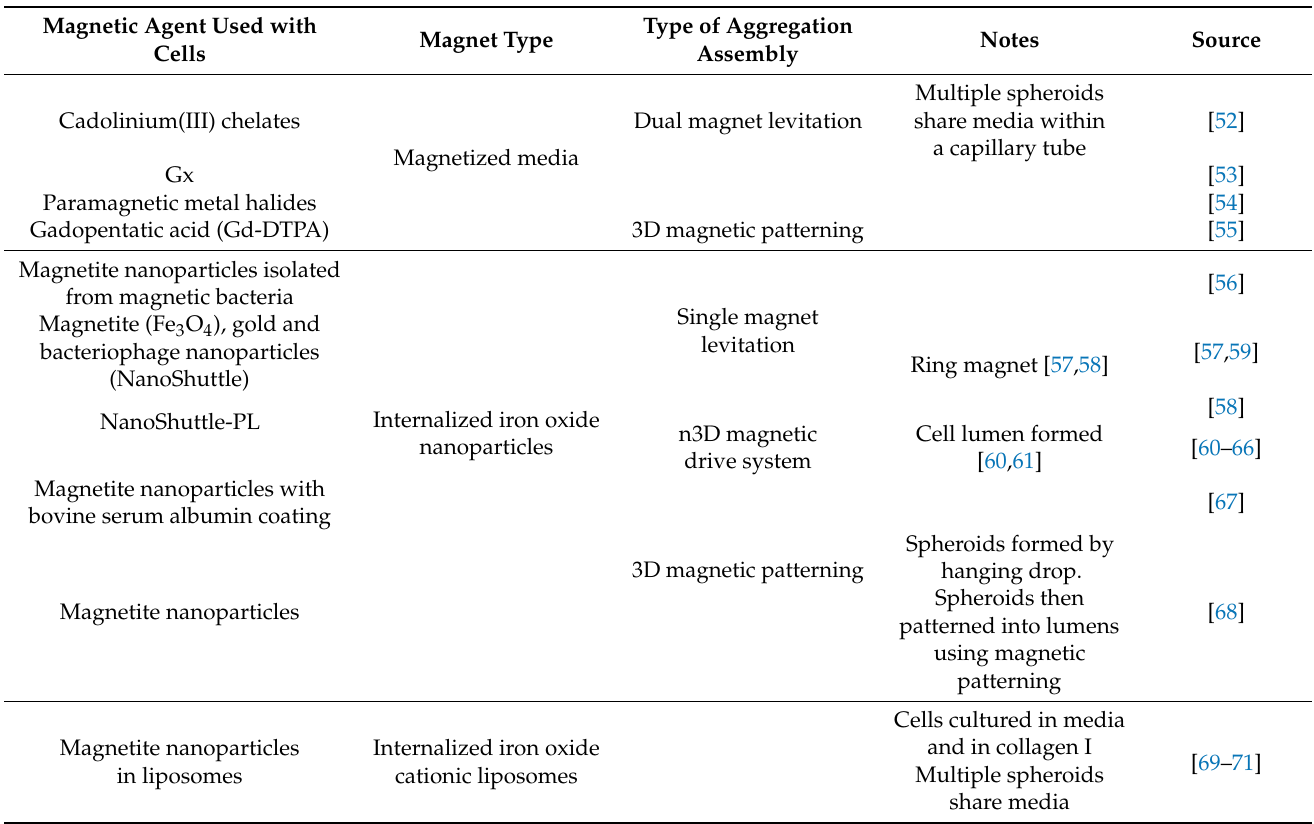
Table 1. Magnetic-based 3D cell